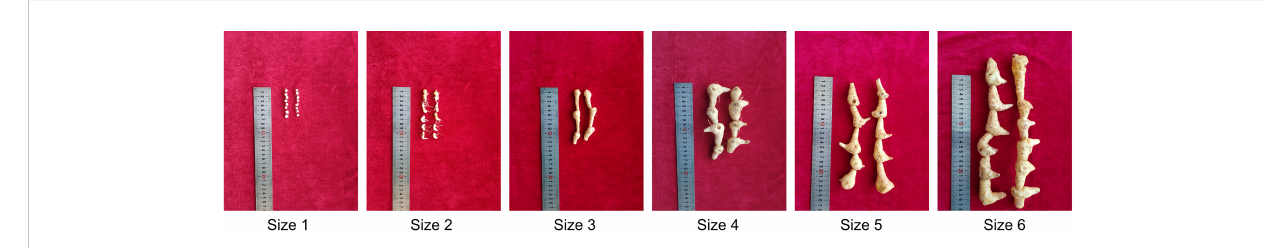
FIGURE 1 The morphology of rhizomes of P. sibiricum at different growth stages. The rhizomes were grouped according to the